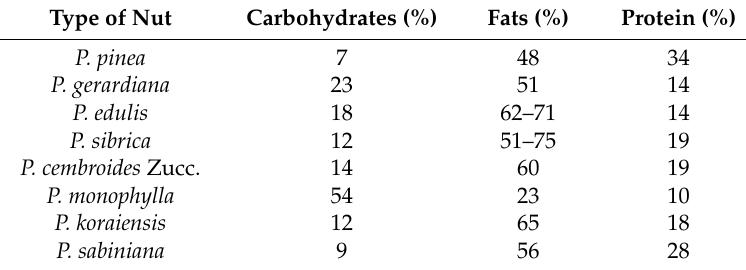
Table 3. Dietary values of several species of pine nuts in comparison with other commercially important nuts 1